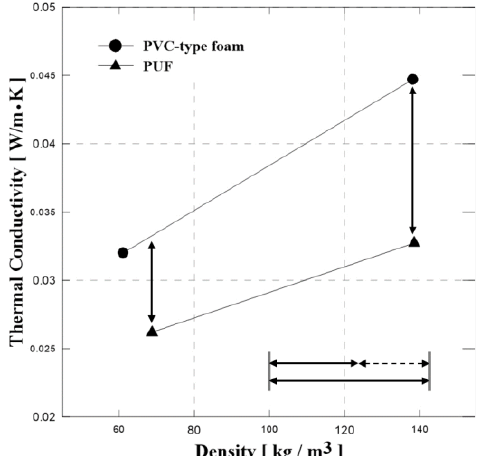
Figure 7. Comparison of thermal conductivity between PVC-type foam and PUF. Table 4. Thermal conductivity of PVC-type foam and neat PUF.